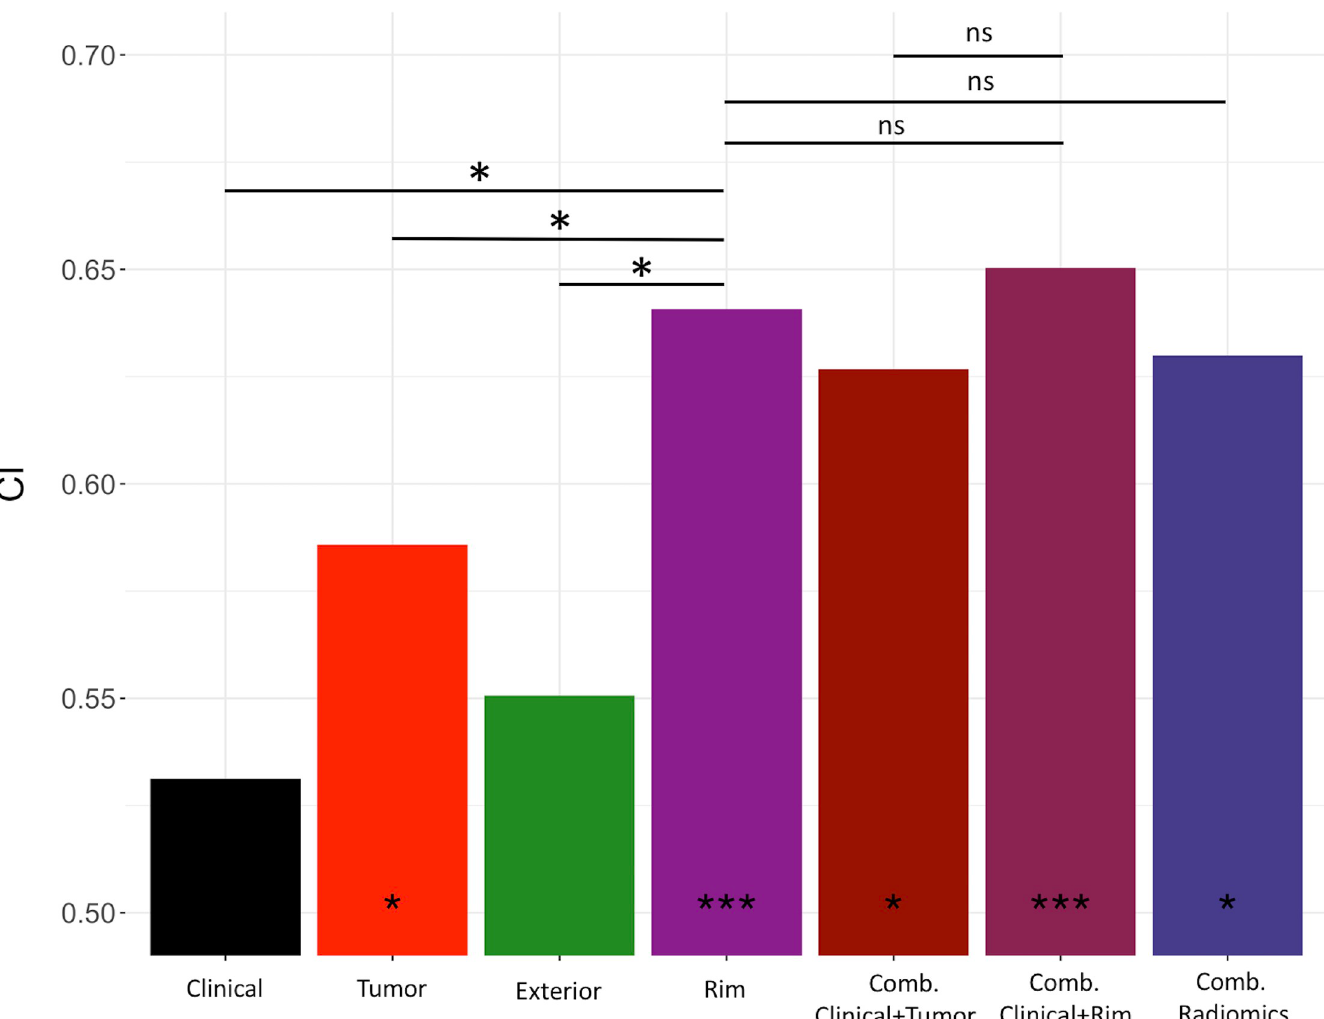
Fig 3. Comparison of prognostic performance across the different multivariable models in the validation cohort (n = 100). � indicates statistical significance (“ � ” indicates p-value < 0.05, “ ��� ” indicates p-value < 0.0001 from random prediction (Noether test)). From left to right, the compared multivariable models include clinical, visible tumor, exterior, tumor rim, combined clinical and tumor, combined clinical and rim, and the combined radiomics model. Crossbars indicate the comparison made between CI of two multivariable models, where � indicates significant difference and ns not statistically significant.